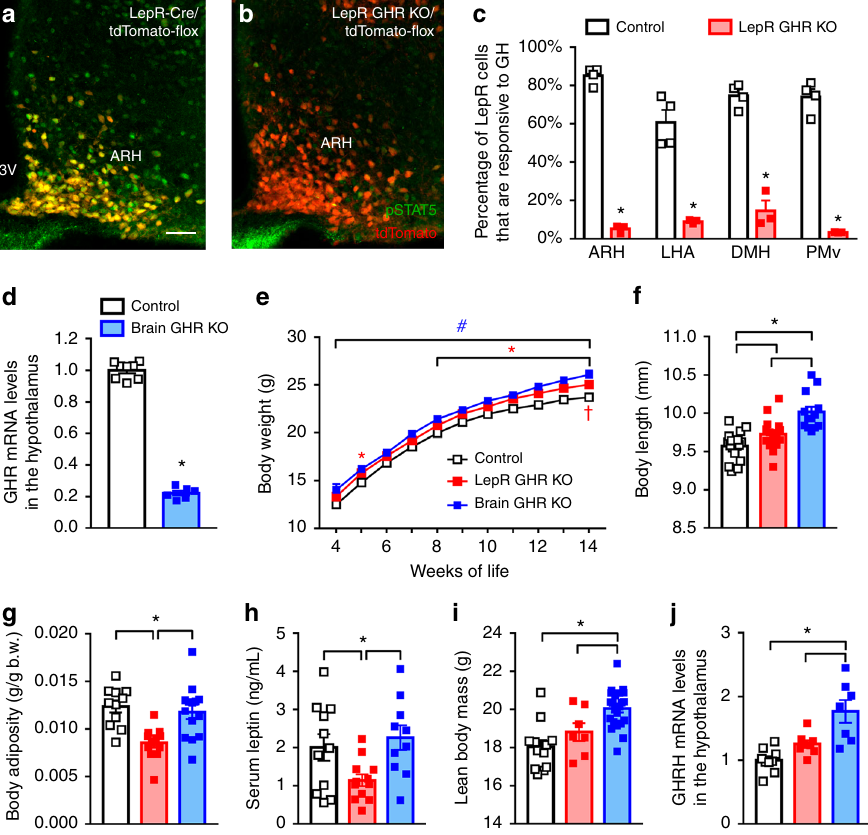
Fig. 5 Consequences of growth hormone receptor (GHR) ablation in leptin receptor (LepR)-expressing cells or the entire brain. a – c A high percentage of LepR neurons (red) in the arcuate nucleus (ARH; t (5) = 28.42, P < 0.0001), lateral hypothalamic area (LHA; t (5) = 6.777, P = 0.0011), dorsomedial nucleus (DMH; t (5) = 10.51, P = 0.0001) and ventral premammillary nucleus (PMv; t (5) = 14.6, P < 0.0001) is responsive to porcine growth hormone (GH) (20 µ